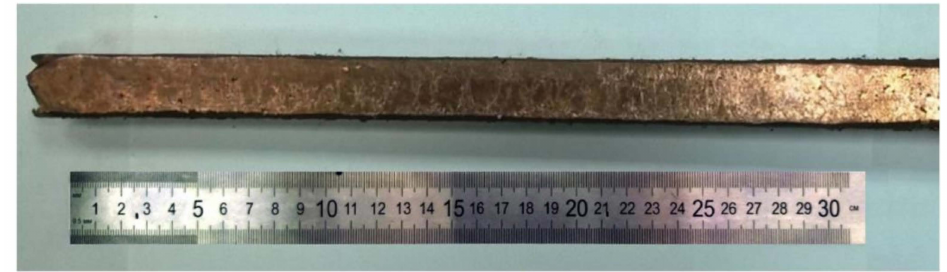
Figure 1. Laboratory samples after radial swaging with a degree of accumulated strain of e = 1.5.